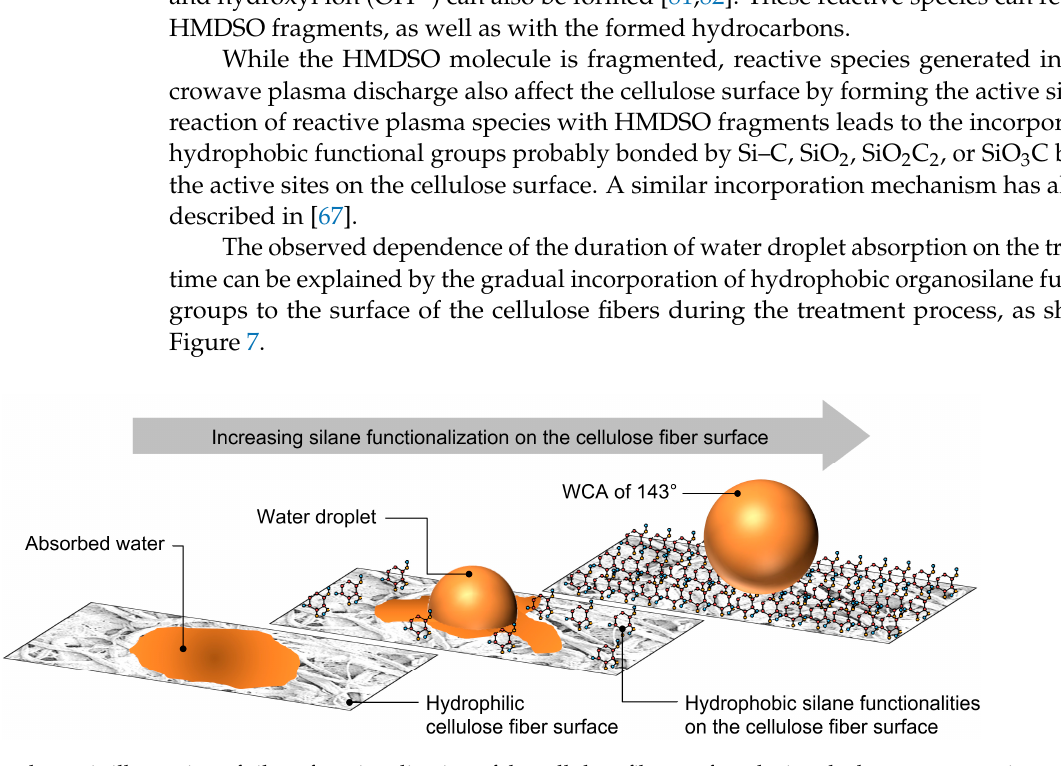
Figure 7. A schematic illustration of silane functionalization of the cellulose fiber surface during the low-pressure microwave plasma treatment in oxygen process gas and its interaction with water droplets.